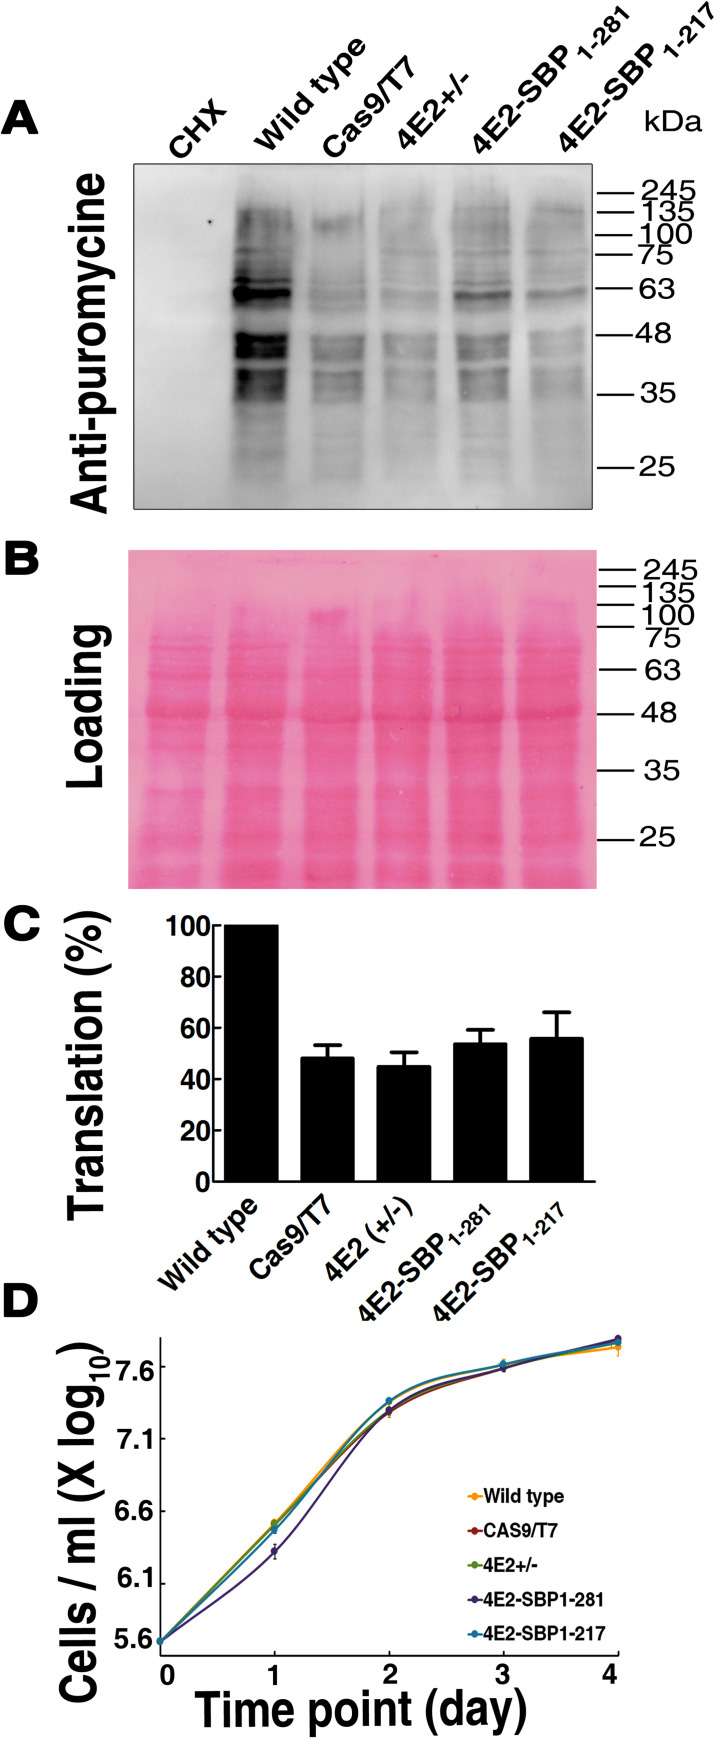
Global translation and growth are not altered in the LeishIF4E2(+/-) mutant cells.(A) LeishIF4E2(+/-) cells, WT, Cas9/T7 expressing cells and transgenic parasites expressing the full length LeishIF4E21-281 and its truncated form devoid of the C-terminus, LeishIF4E21-217 were incubated with 1 μg/mL puromycin for 1 hr. Cycloheximide treated cells were used as a negative control for complete inhibition of translation. Puromycin treated cells were lysed and resolved over 12% SDS-PAGE and subjected to western analysis using antibodies against puromycin. (B) Ponceau staining was used to indicate comparable protein loads. (C) Densitometry analysis of puromycin incorporation in the different cells lines, was compared to WT cells (considered as 100%). Data from all three independent experiments are represented. (D) All cells were cultured at 25 oC in M199 containing essential nutrients. Cell counts were monitored daily during 4 consecutive days. The curves were obtained from three independent assays, error bars are also marked. Growth curves of WT cells are shown in yellow, Cas9/T7 are in brown, the LeishIF4E2(+/-) mutant cells are in green, cells expressing the full length LeishIF4E2 1–281 are in purple, and the truncated LeishIF4E21-217 cells are in blue.